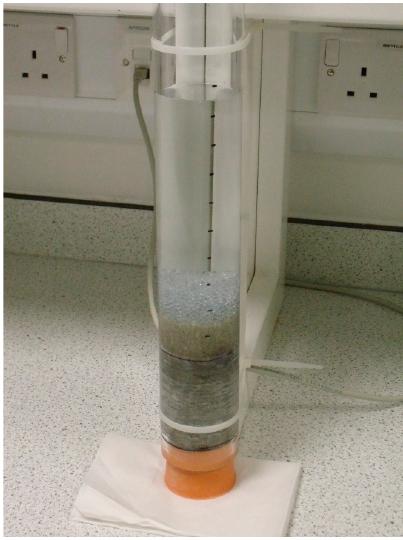
Figure 5. Hydration of bentonite block in polycarbonate tube.